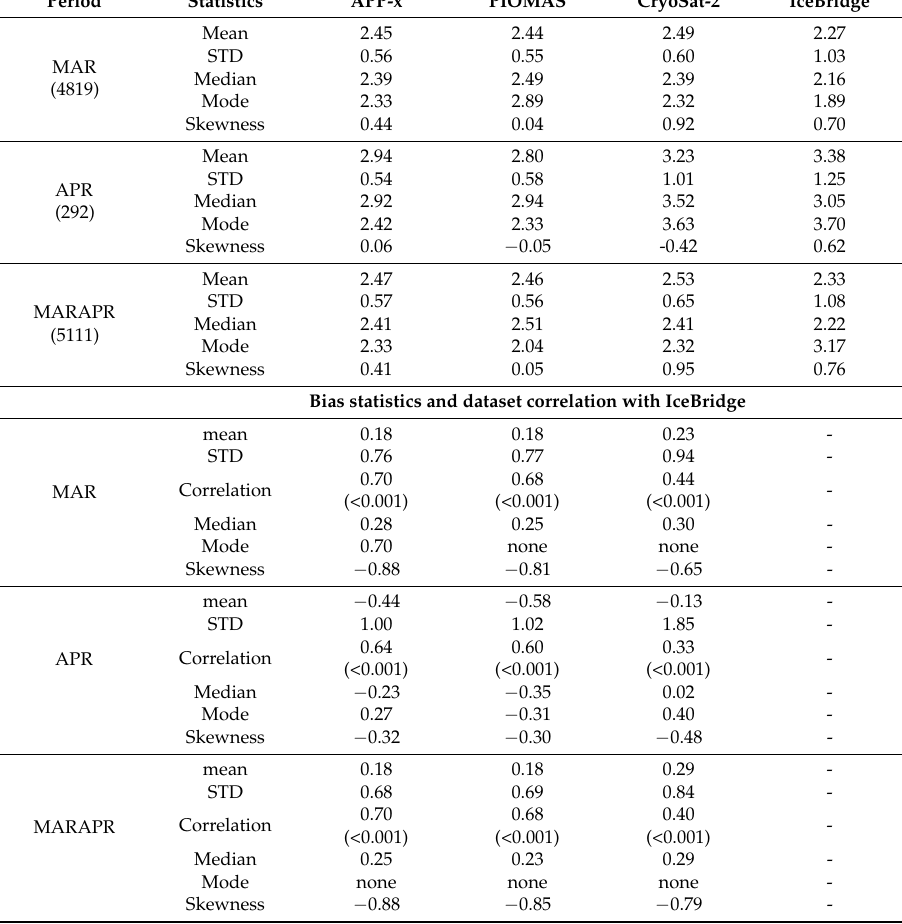
Table 4. Descriptive statistics of the ice thickness (top half) in five datasets and their differences and correlation with IceBridge thickness (bottom half) in the two IceBridge periods (meters). MAR is March; APR is April; MARAPR is March and April. The number in parentheses beneath the period name is the total number of pixels used for the comparison in that period. P-values are given in parentheses beneath the correlation coefficients.